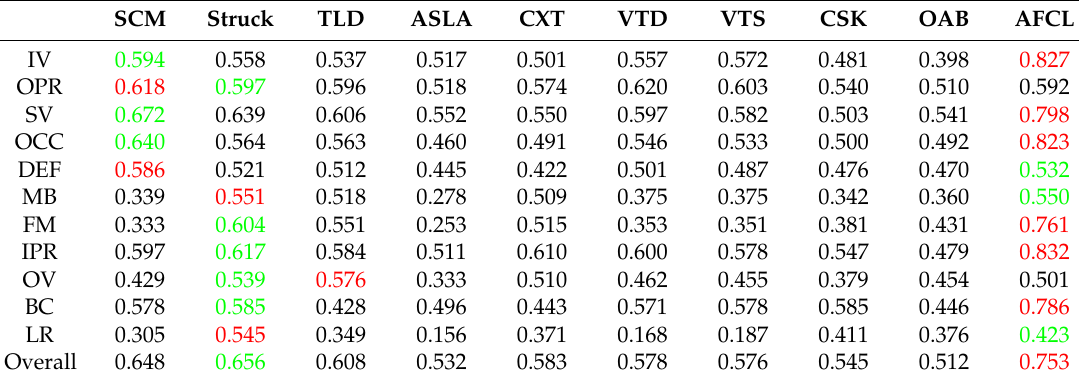
Table 2. Average precision scores on different attributes: IV (illumination variation), OPR (out-of-plane rotation), SV (scale variation), OCC (occlusion), DEF (deformation), MB (motion blur), FM (fast motion), IPR (in-plane rotation), OV (out-of-view), BC (background cluttered) and LR (low resolution). The best results are in red and the second best results are in green.